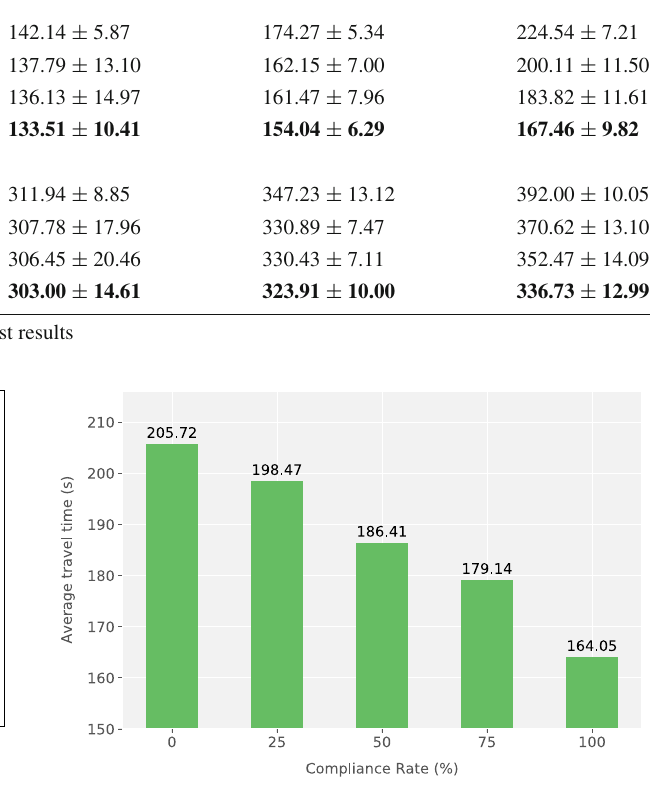
Fig. 8 Average fuel consumption results of traffic routing methods in the Gangnam district traffic network scenario